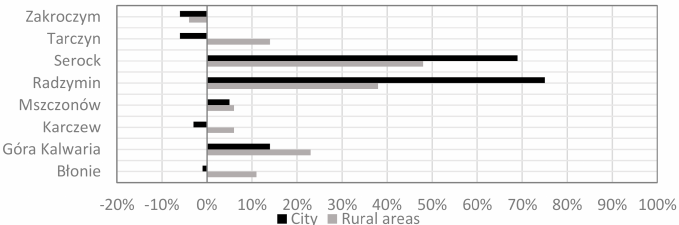
Figure 5. The change in the number of inhabitants in the studied cities and in their rural areas in the years 1995–2018 (for Tarczyn, the analysis concerned the period 2002–2018). Source: own study based on the data of the Central Statistical O ffi ce of Poland, Local Data